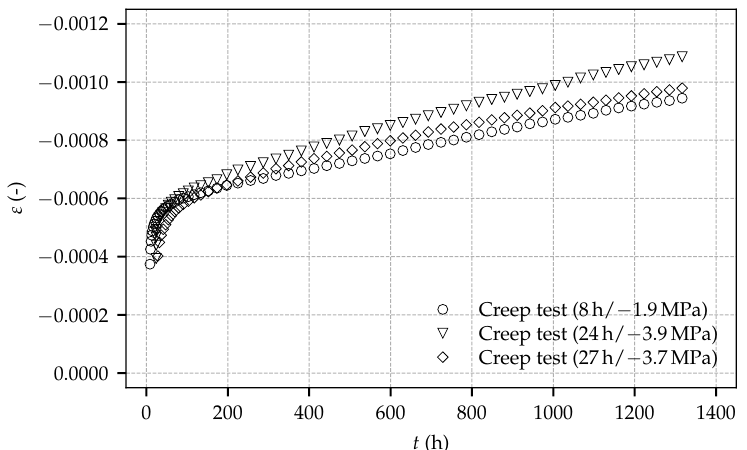
Figure 7. Evolution of the total strain determined on sealed, loaded specimens: experimental results for the tests on three specimens of the present experimental program, started at shotcrete ages of 8 h, 24 h and 27